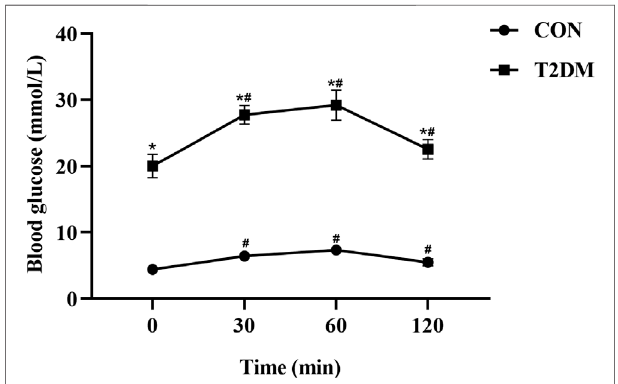
FIGURE 1 | The levels of glucose during the OGTT in the control and T2DMrats.* p < 0.05,comparedwithratsinCONgroup; # p < 0.05,compared with blood glucose value in the 0 min.